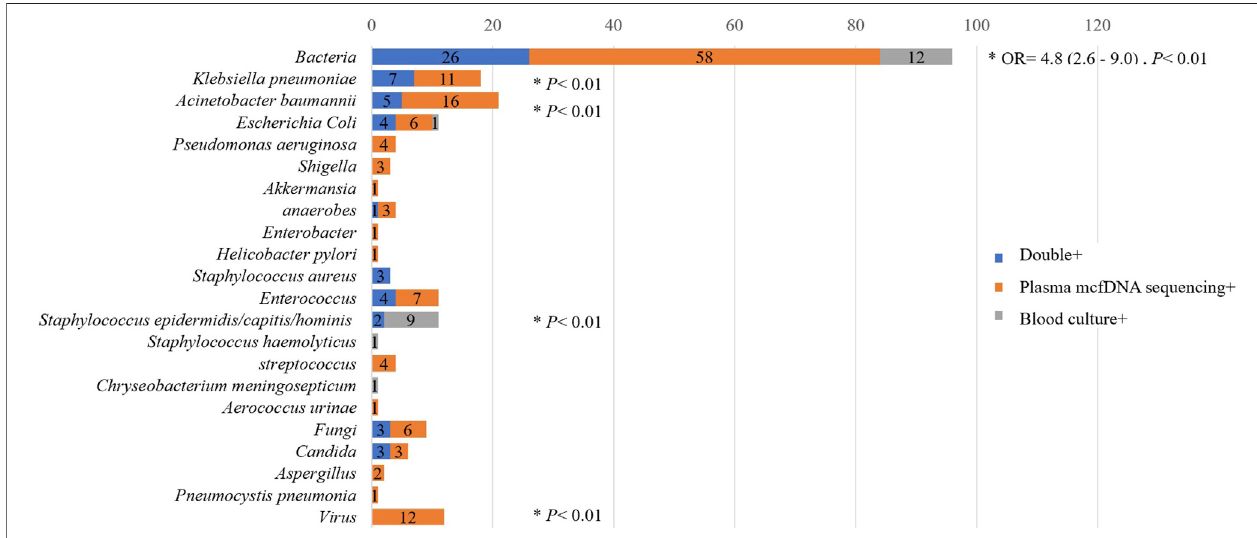
FIGURE 6 | Comparison of plasma microbial cell-free DNA (mcfDNA) sequencing and blood culture testing by in terms of